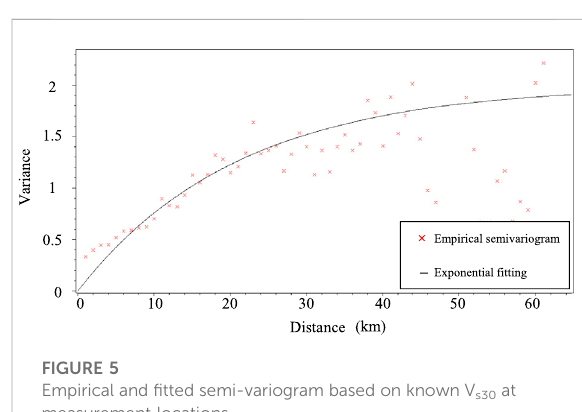
Empirical and fi tted semi-variogram based on known V s30 at measurement